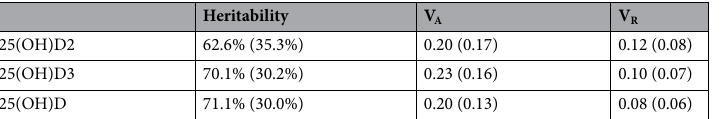
Table 2. Heritability and variance components of serum 25(OH)D concentration. The brackets represent the standard errors on the estimates. V A additive genetic variance; V R residual